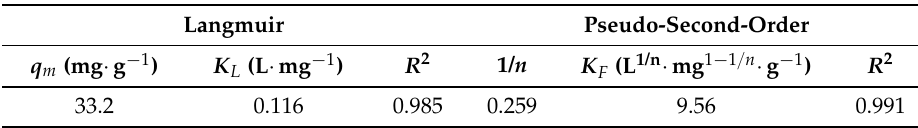
Table 4. Isotherm parameters for Cu(II) adsorption onto